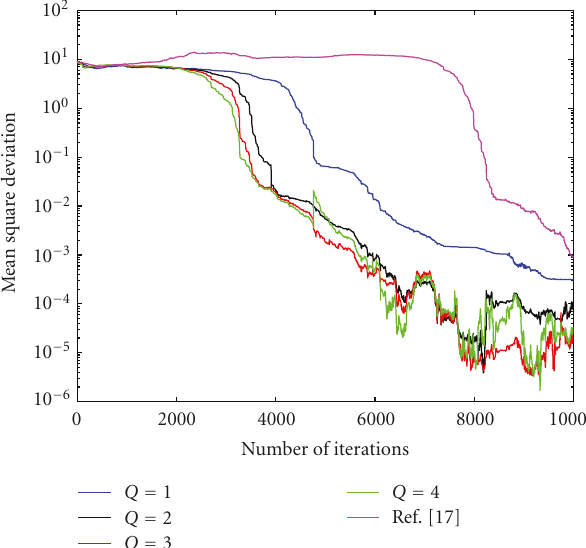
Figure 2: Mean square deviation learning curve of the proposed algorithm for varying constraint. Figure 3: Mean square deviation learning curves of the proposed algorithm for varying constraint and a colored input